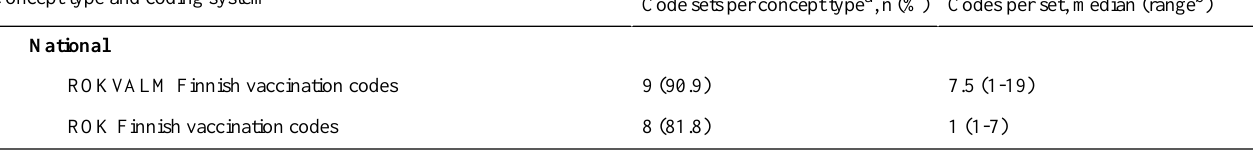
the clinical concept.